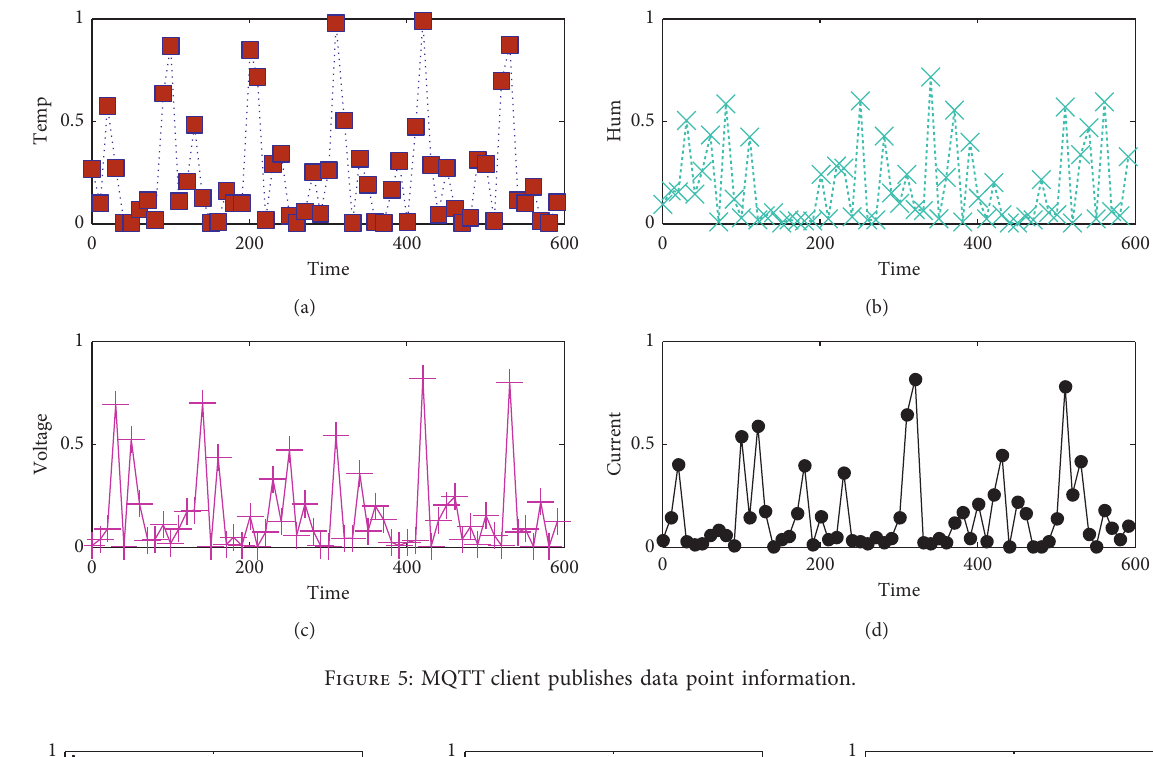
Figure 5: MQTT client publishes data point information.